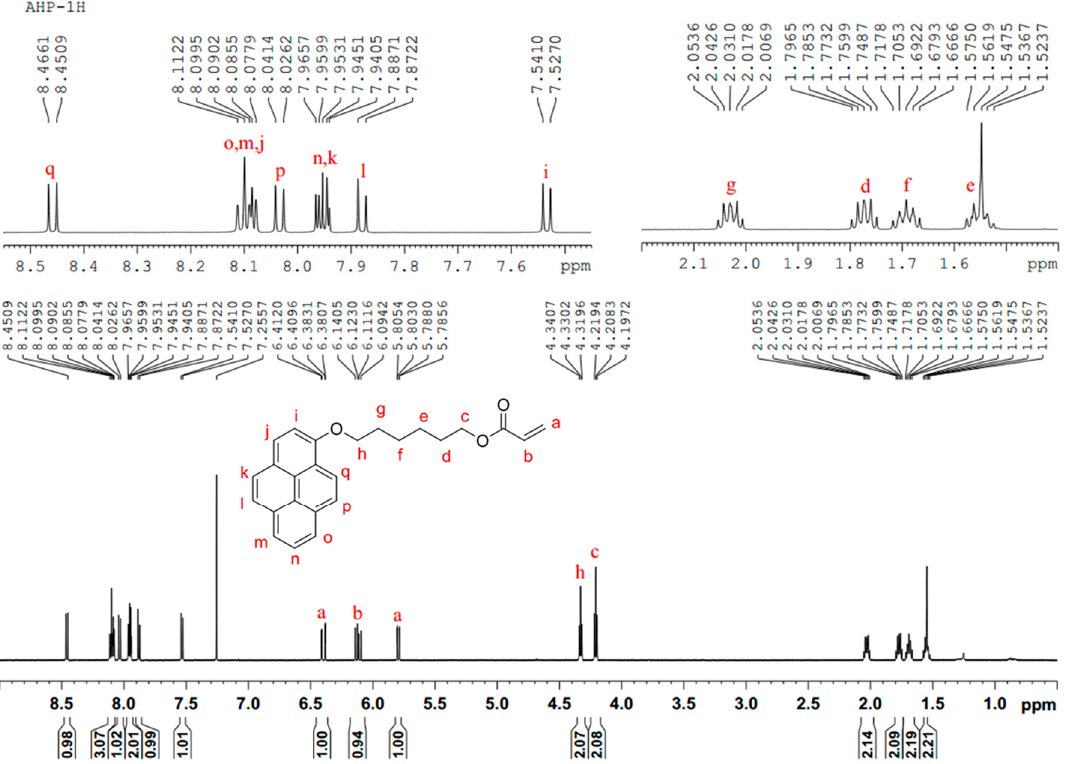
Figure 1. 1 H NMR spectrum of AHP in CDCl 3 .